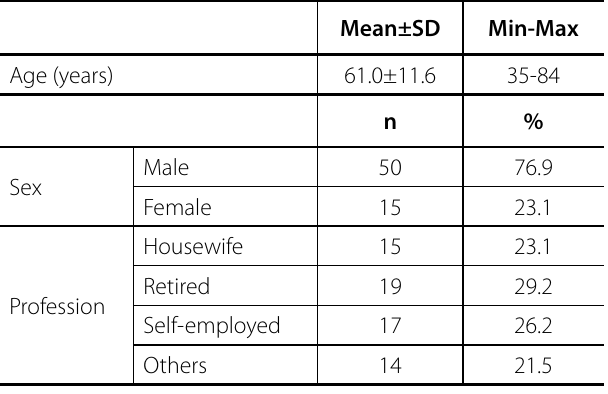
Table 1 . Patients’ demographical data.